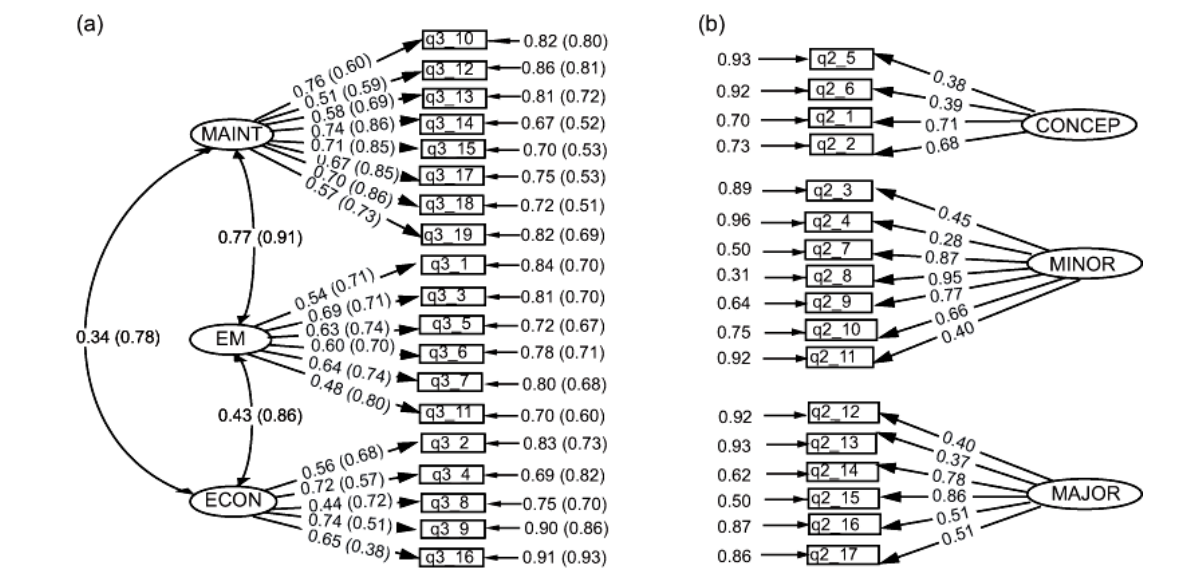
Fig. 3 . (a) Forest owner representations of forest management: maintenance forest management (MAINT), ecosystem-centered management (EM), and economics-centered management (ECON). Standardized parameters reported for efficient owners, in parentheses for inefficient owners. (b) Factors preventing forest owners from cutting more: conceptual constraints (CONCEP), physical constraints (MINOR), and potentially removable constraints (MAJOR). All parameters significant at P <